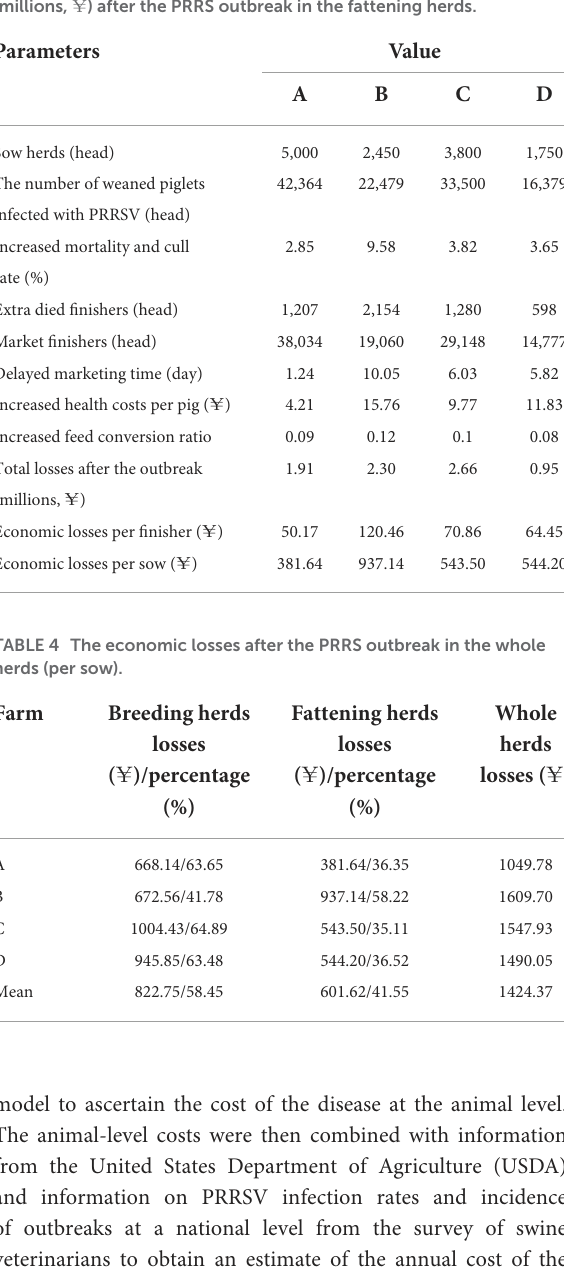
TABLE 2 The economic losses after the PRRS outbreak in the breeding herds.